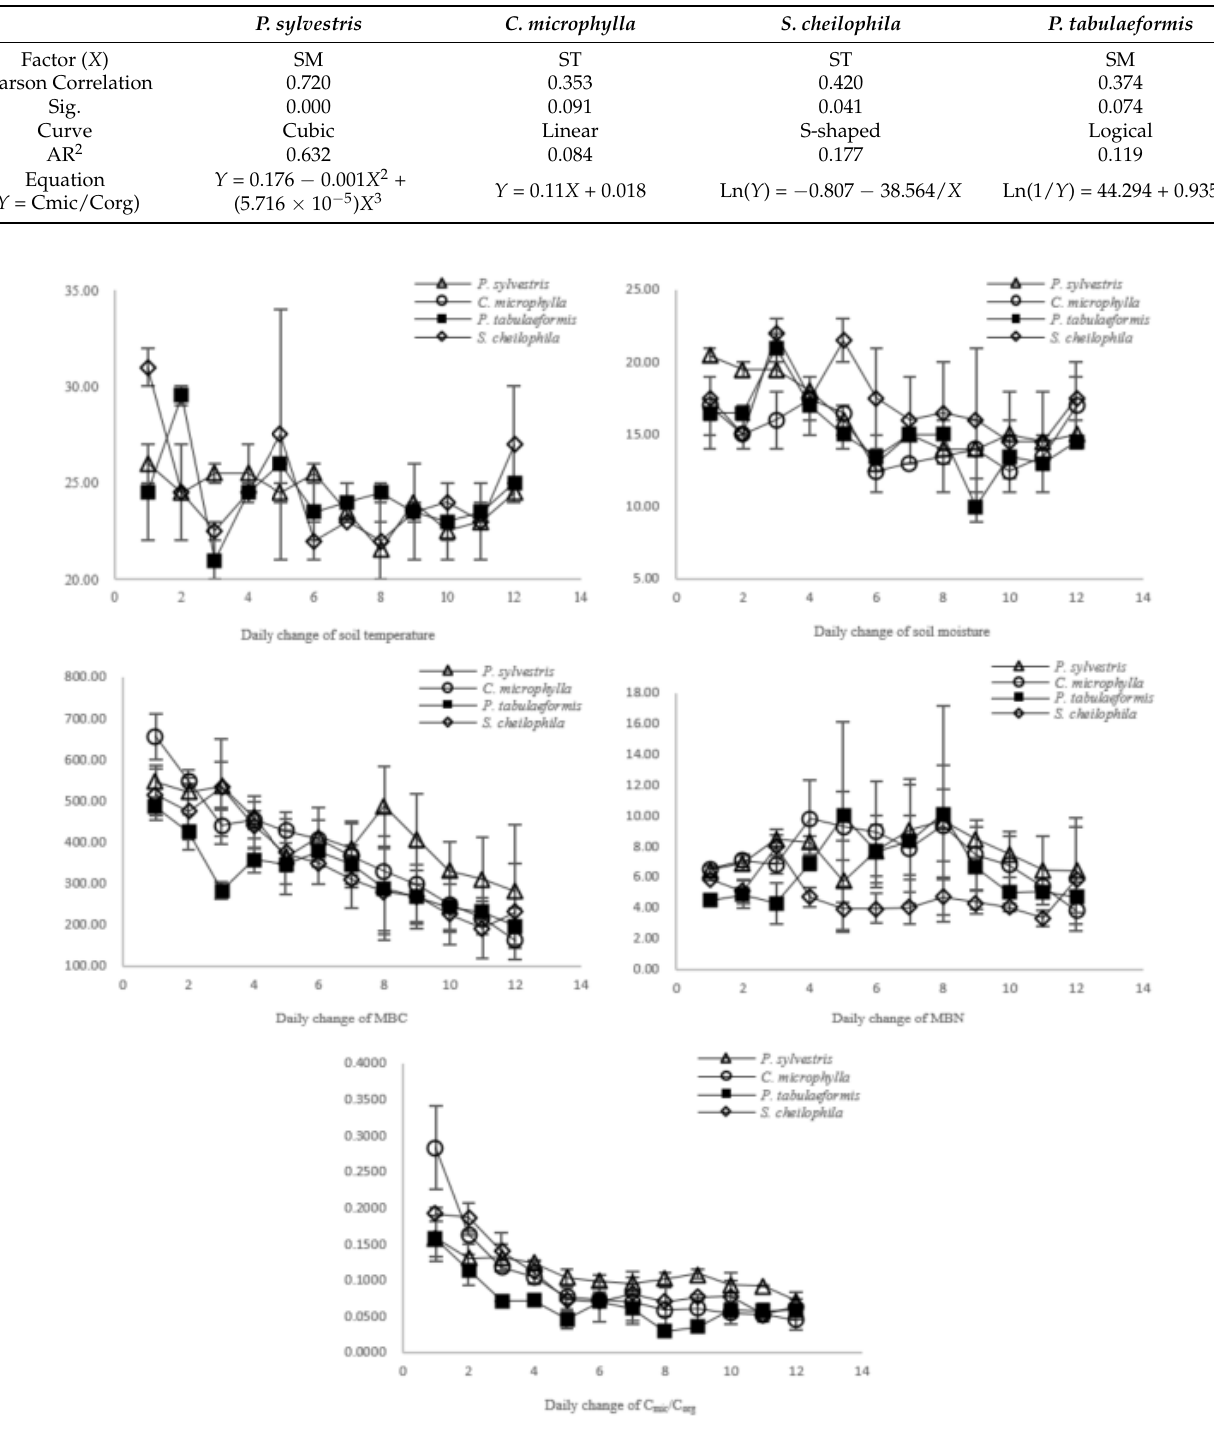
Table 2. Regression curve coefficients.